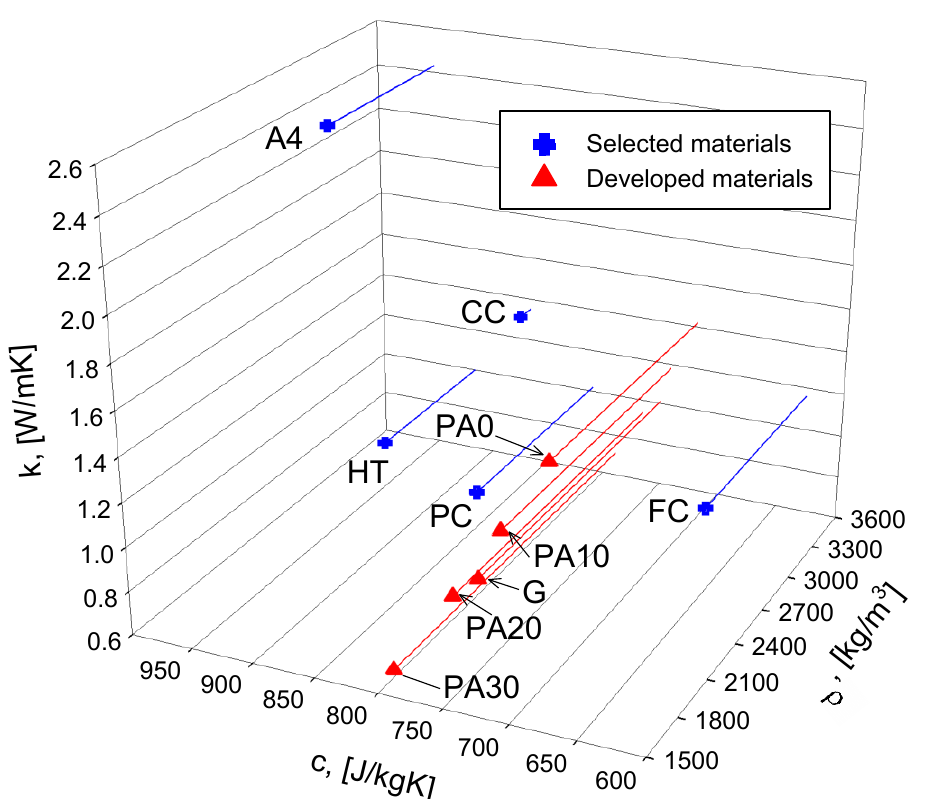
Figure 12. 3D graph for thermal properties of storage